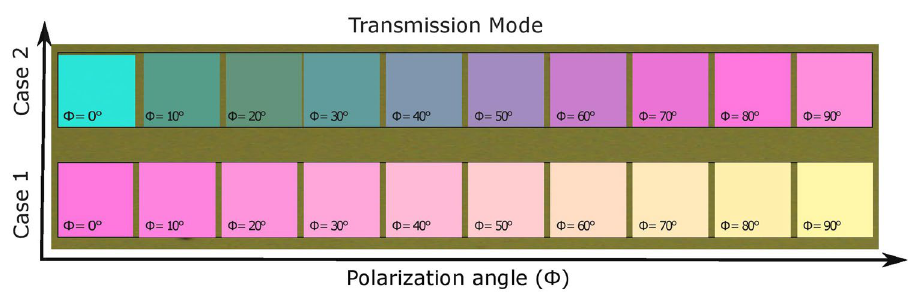
Figure 5. Colors visible under optical microscope in transmission mode when Φ is gradually varied from 0° to 90°. Dimensions of nanoantennas are given in Table 1.